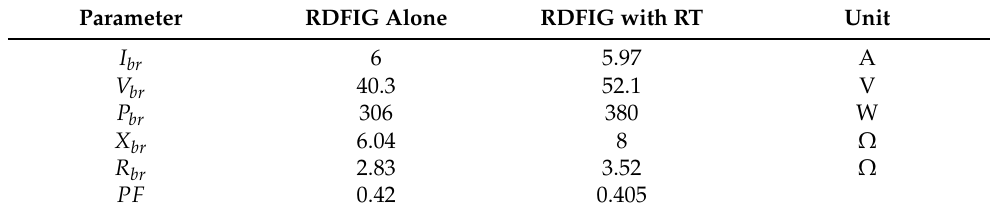
Table 8. Rotary transformer–RDFIG blocked rotor tests.